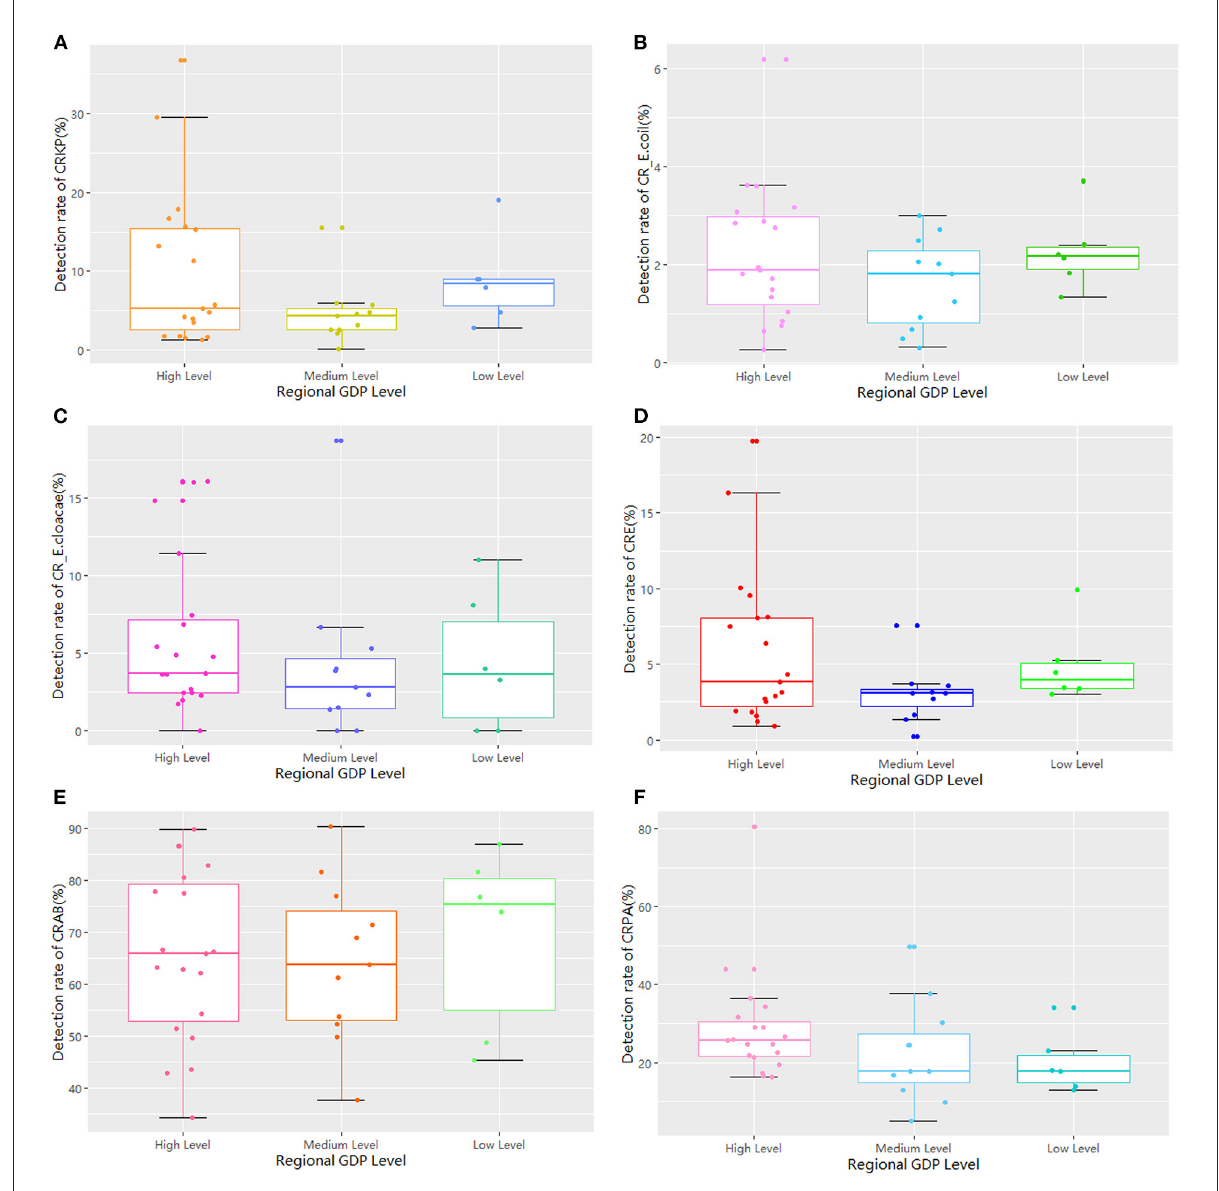
FIGURE6 The comparison of detection rates of GRNB based on regional per capita